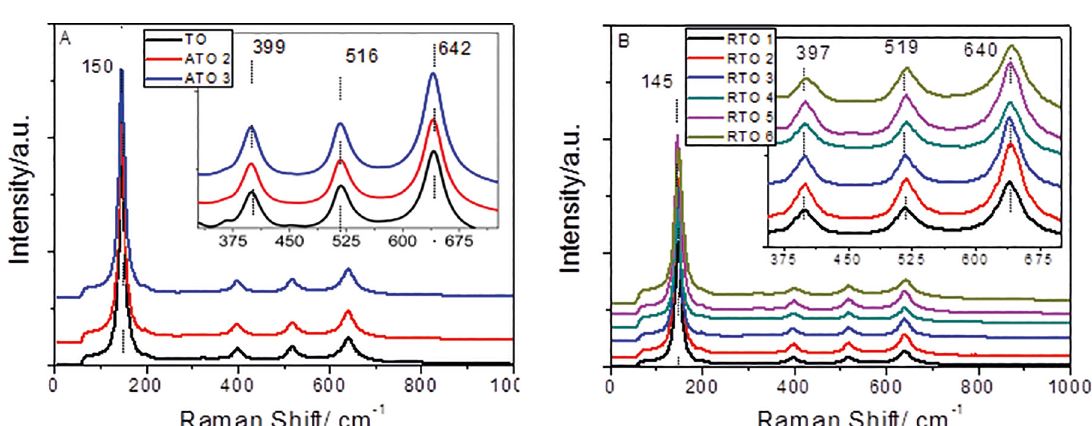
Figure 4. (A) Raman spectra between 0 and 1000 cm -1 . Insert: Raman spectra between 300 and 700 cm −1 of samples TO, ATO-2, and ATO-3. (B) Raman spectra between 0 and 1000 cm -1 . Insert: Raman spectra between 300 and 700 cm −1 of samples RTO-1, RTO-2, RTO- 3, RTO-4, RTO-5, and